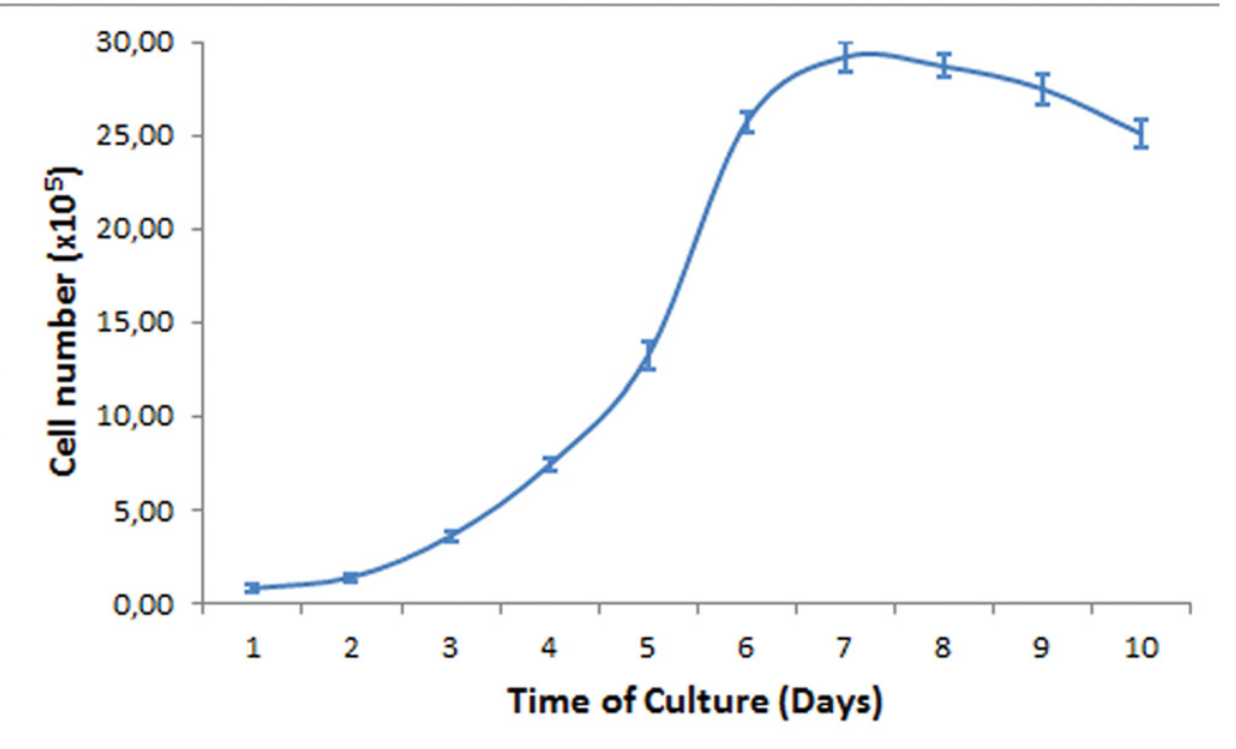
Fig 4. Growth curve of IPC-366 at 30th